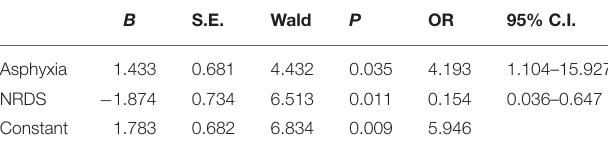
TABLE 3 | Logistic regression analysis.